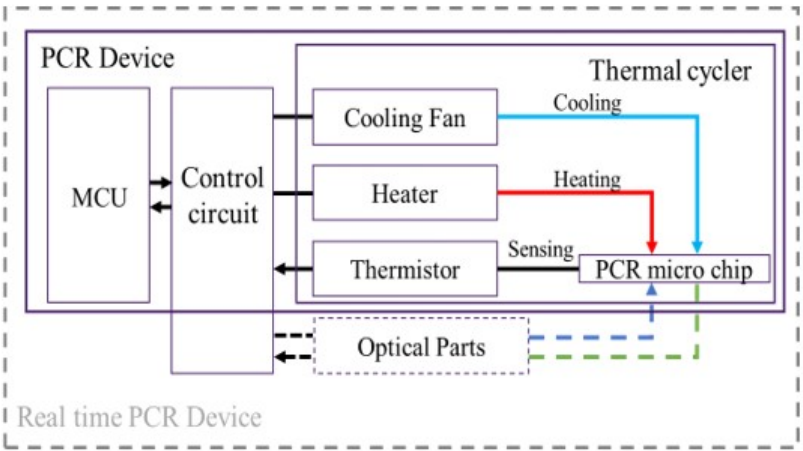
Figure 2. An overview of the PCR device, including a thermal cycler, control circuit, and microcon- troller unit (MCU).